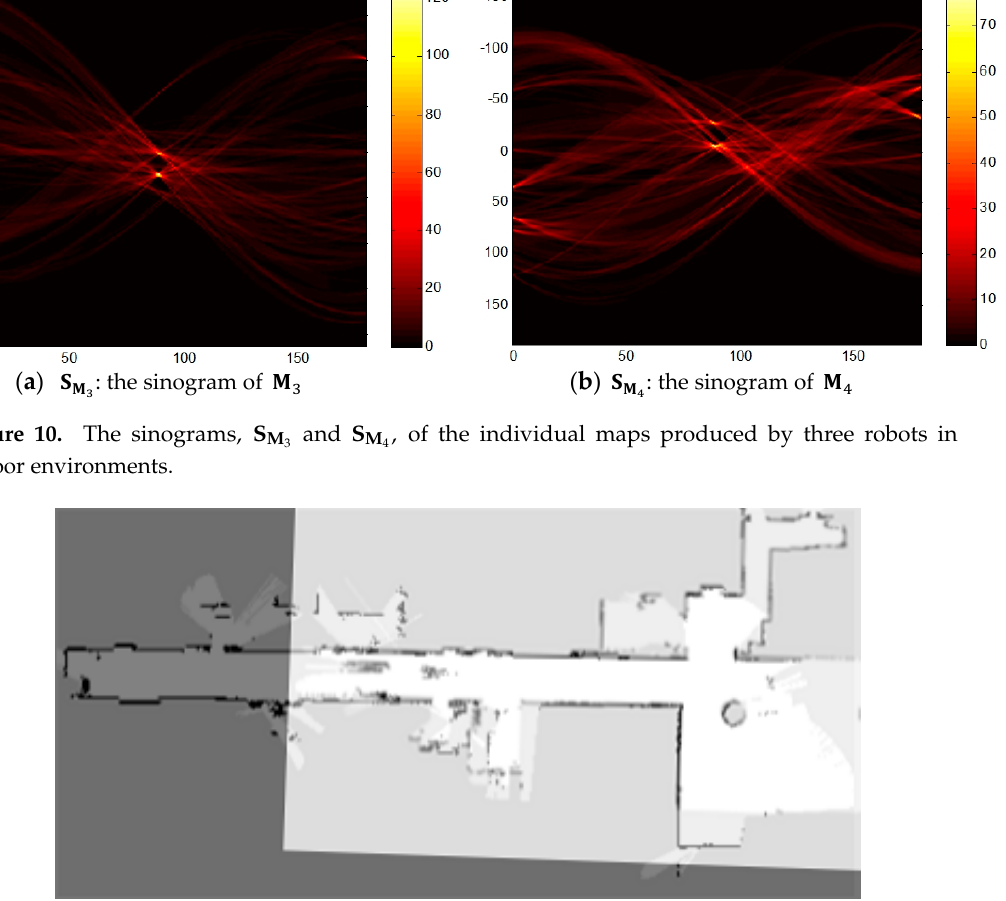
Figure 11. The result of merging the individual maps, 𝐌 (cid:2871) and 𝐌 (cid:2872) , which are produced from experiments.